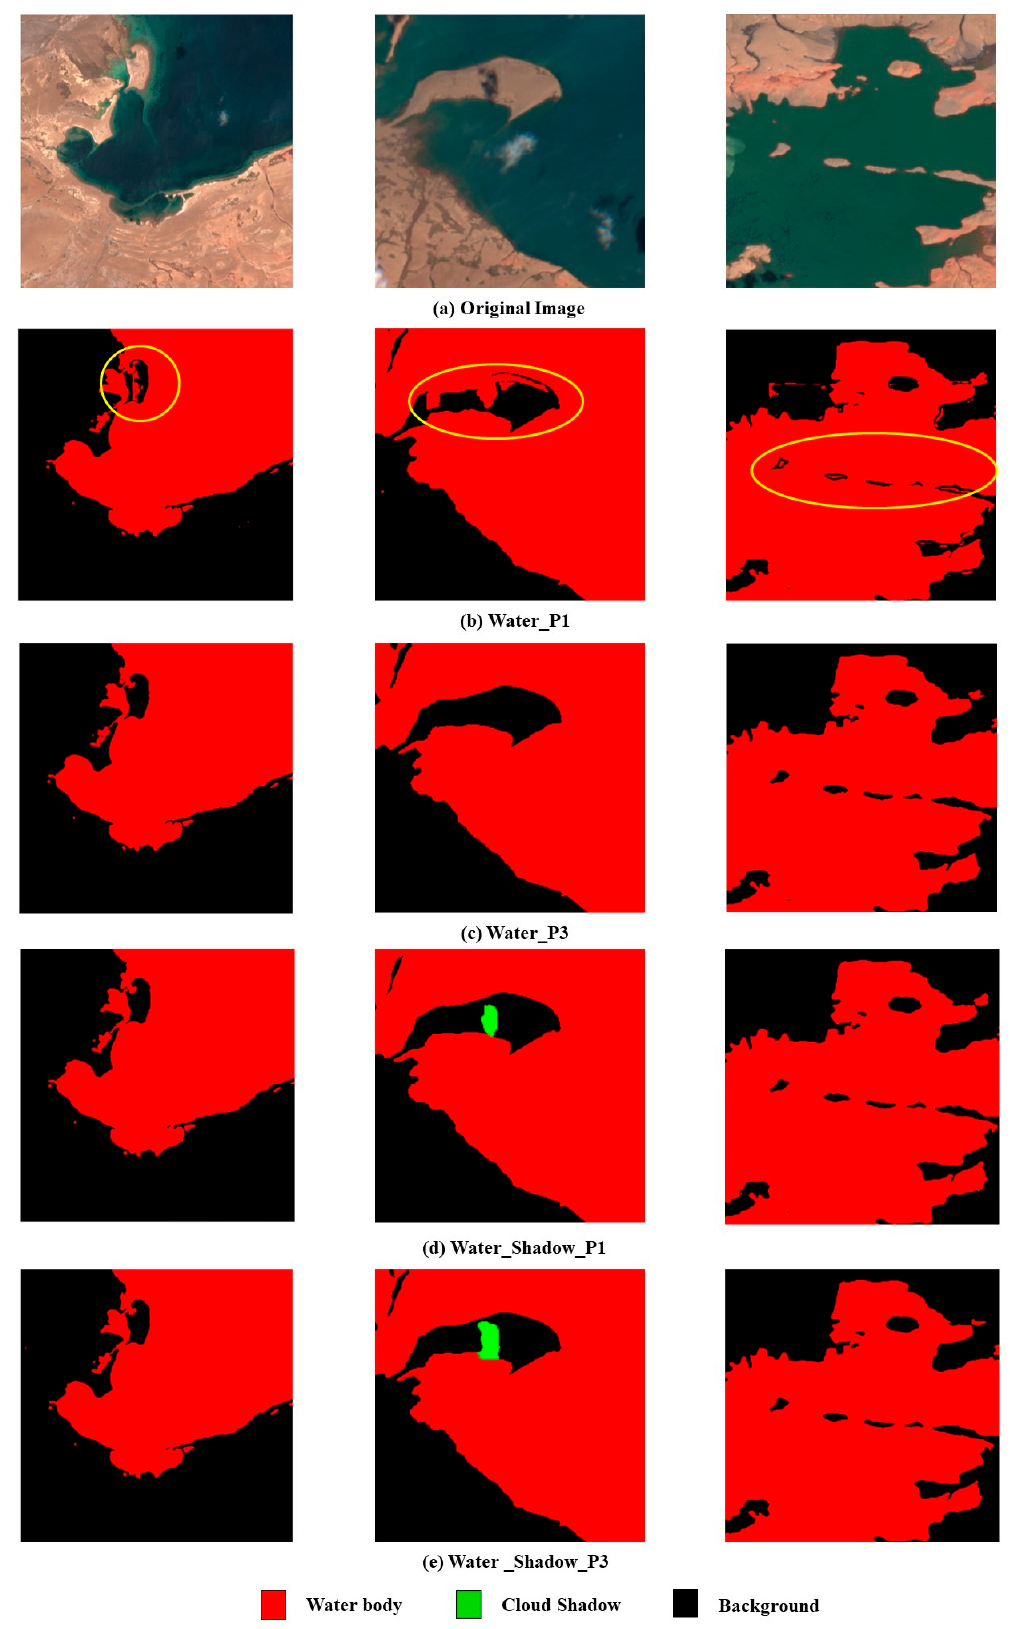
Figure 7. Results of the middle part of islands being misclassified as water body (The areas circled in yellow represent the middle part of islands being misclassified as water body).